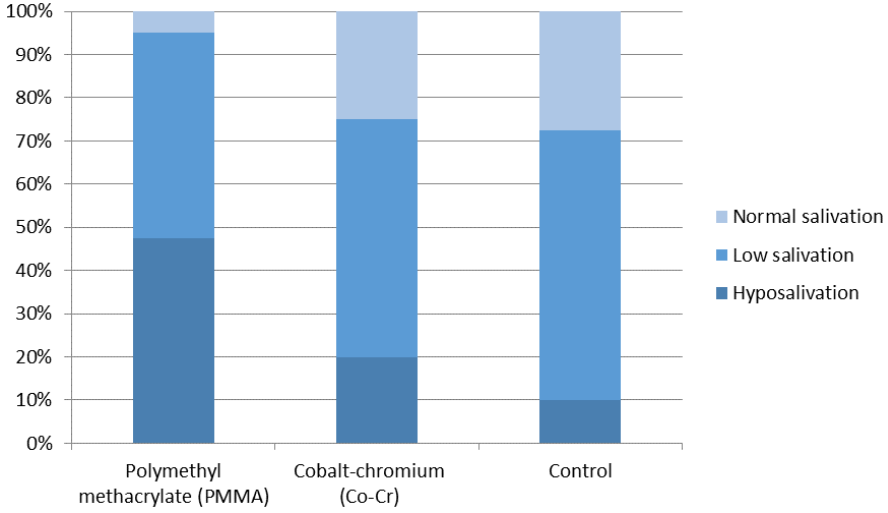
Figure 1. Salivary flow rate in investigated groups.